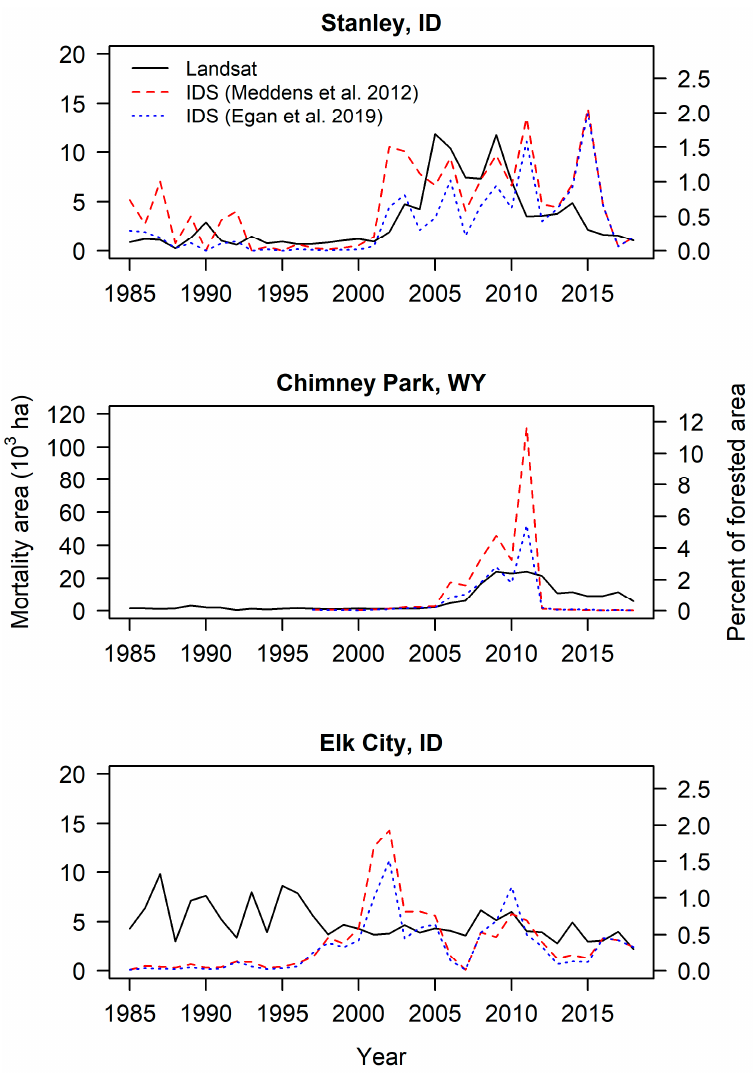
Figure 6. Annual estimates of total mortality area across 1 × 1 degree extents from Landsat and insect and disease survey (IDS) polygon data. Wilderness areas, where IDS surveys are conducted infrequently, were excluded.